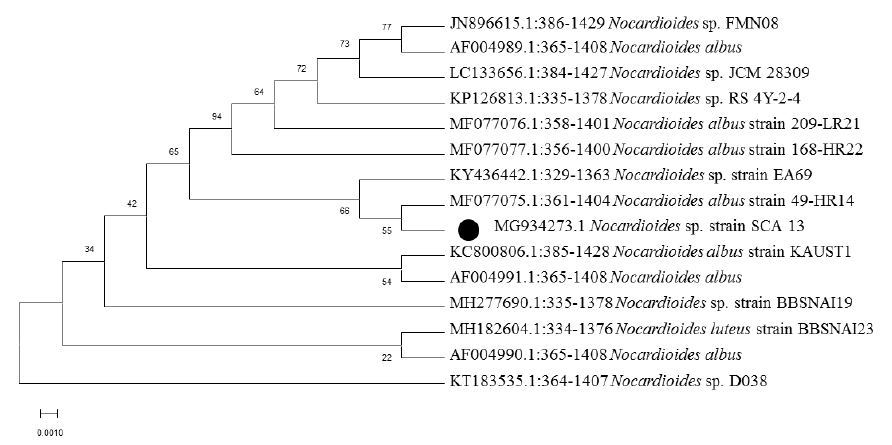
Figure 4. Phylogenetic analysis of isolate Nocardioides sp. strain SCA13. Neighbor-joining phylogenetic tree showing evolutionary relationship of selected isolate based on 16S r-RNA sequence alignments. Bootstrap values at the nodes indicate collated values based on 1000 resampleddatasets. Bar indicates 0.001 substitutions per nucleotide position.